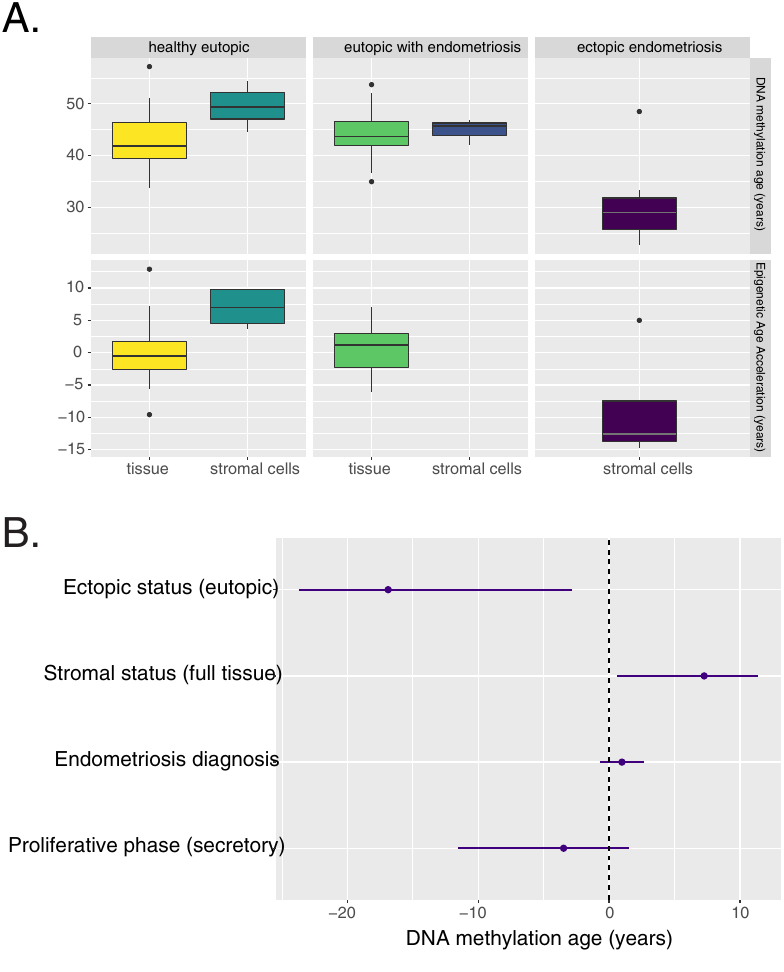
Figure 3. ( A ) DNA methylation age and Epigenetic Age Acceleration (EAA) of whole tissue as compared to isolated stromal cell populations. The age acceleration observed in stromal cells may be due to the effect of passaging. Healthy tissue: n = 34; Healthy stromal cells: n = 8; Eutopic tissue (endometriosis): n = 26; Eutopic stromal cells (endometriosis): n = 3; Ectopic stromal cells: n = 7. ( B ) Values of the coefficients estimated from the multivariate linear regression model; the point estimates are shown as points while the lines represent a bootstrapped 95% confidence interval. If the line crosses 0, the effect is not significant at 95% confidence. Age coefficient can be found in Fig.